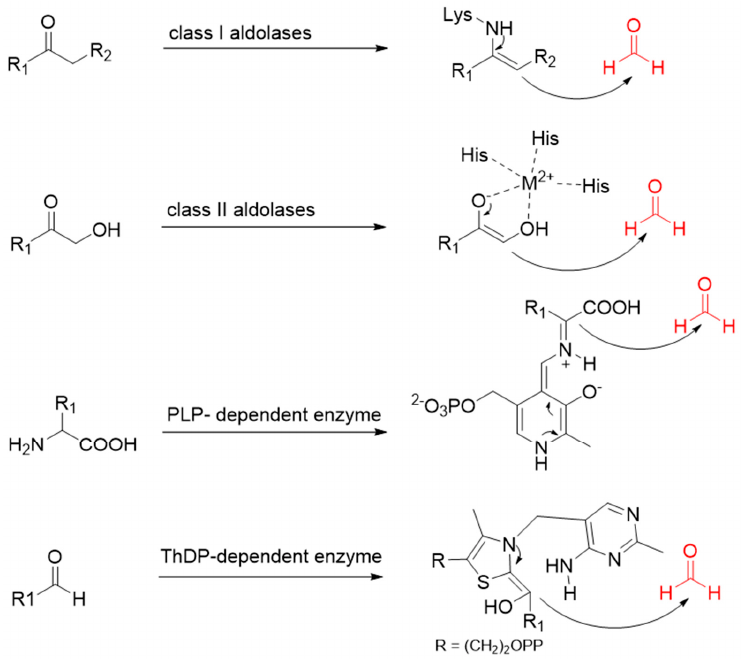
Figure 9. Four types of C-C Ligases for formaldehyde biotransformation [18].